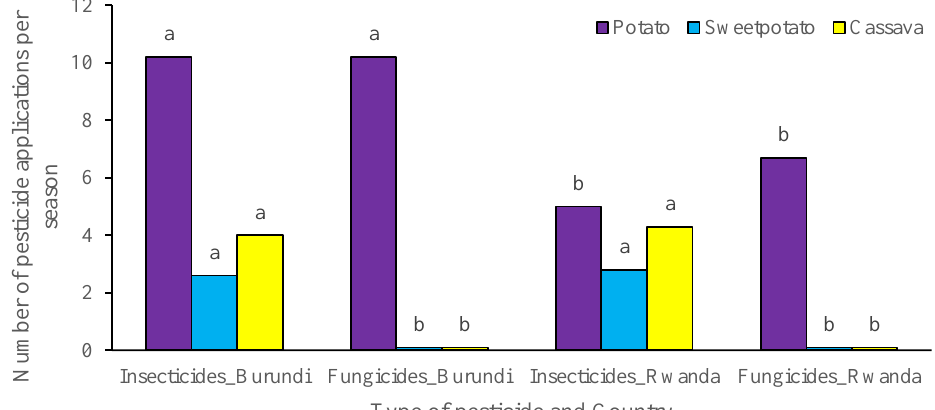
Figure 5. Frequency of pesticide applications by farmers of RTB crops in Rwanda and Burundi. For mean bars with the same letter per crop, no significant statistical difference at p ≤ 0.05 exists between countries (for the same pesticide type).